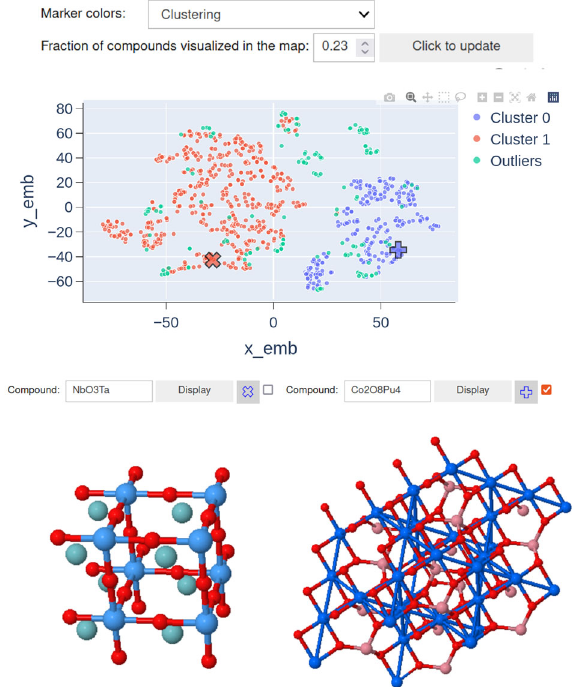
Fig. 2 Snapshot of the Visualizer in the ‘ Querying the Archive and performing Arti fi cial Intelligence modeling ’ notebook. The visua- lization of a two-dimensional map allows to identify subsets (in AI nomenclature: clusters) of materials with similar properties. Two windows at the bottom of the map allow to view the structures of the compounds in the map. Clicking a point shows the structure of the selected material. Ticking the box on top of the windows selects which one of the two windows is used for the next visualization. The two windows have different types of symbols (here, crosses) to mark the position on the map. It is also possible to display a speci fi c material chosen from the Compound text box to show its structure and its position on the map, which is then labeled with a cross. In this fi gure, two compounds are visualized, and it is possible to spot the position of the materials on the